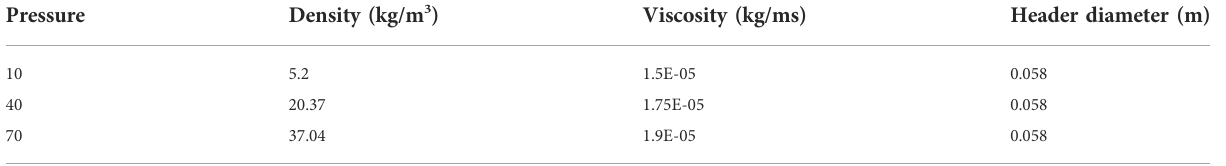
TABLE 2 Properties of steam at different pressures and header